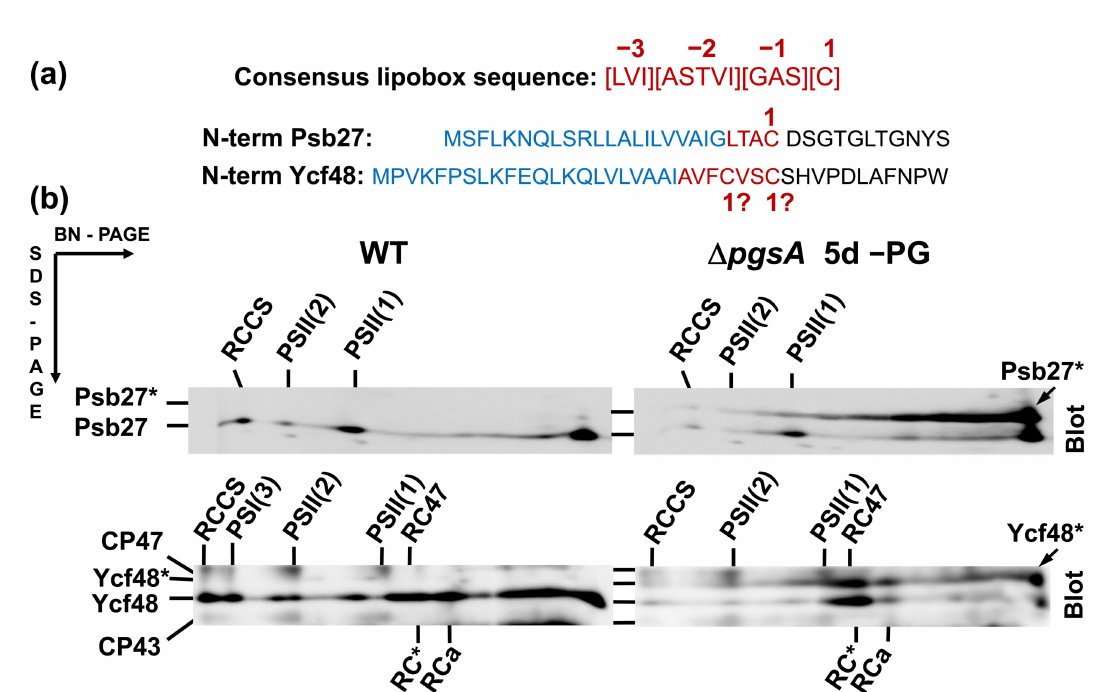
Figure 1. Comparison of the consensus lipobox sequence and N -terminal sequences of Psb27 and Ycf48 with designation of signal peptide (blue) and putative lipobox sequences (red) ( a ), and forms of Psb27 and Ycf48 detected in membranes of the Synechocystis wild-type (WT) cells and in cells of the ∆ pgsA mutant after 5 days of phosphatidylglycerol (PG) depletion ( b ). Membrane proteins were separated by 2D BN/SDS-PAGE, the gel was blotted to a polyvinylidene difluoride membrane, and Psb27 and Ycf48 were detected by the specific antibodies. Designation of complexes and proteins: RCCS, supercomplex of PSI and PSII; PSI(3), trimer of photosystem I; PSII(1) and PSII(2), monomeric and dimeric photosystem II; RC47, PSII(1) lacking CP43; Psb27*, and Ycf48*, preprotein versions of both proteins still containing signal peptides for translocation into the lumen. Five micrograms of Chl were loaded for each